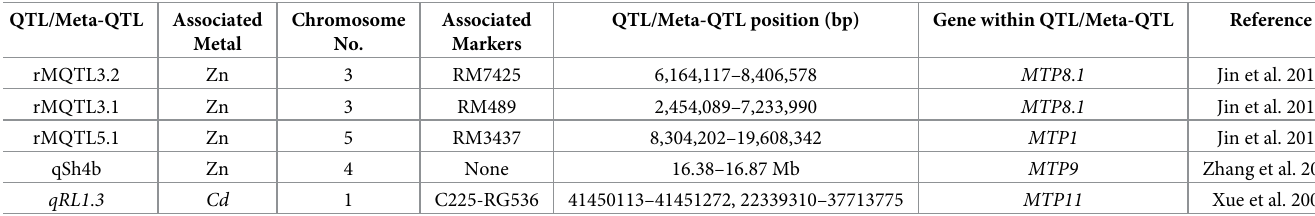
Table 4. Presence of MTP genes in various rice QTLs/meta-QTLs associated with metal tolerance/accumulation. QTL/Meta-QTL Associated